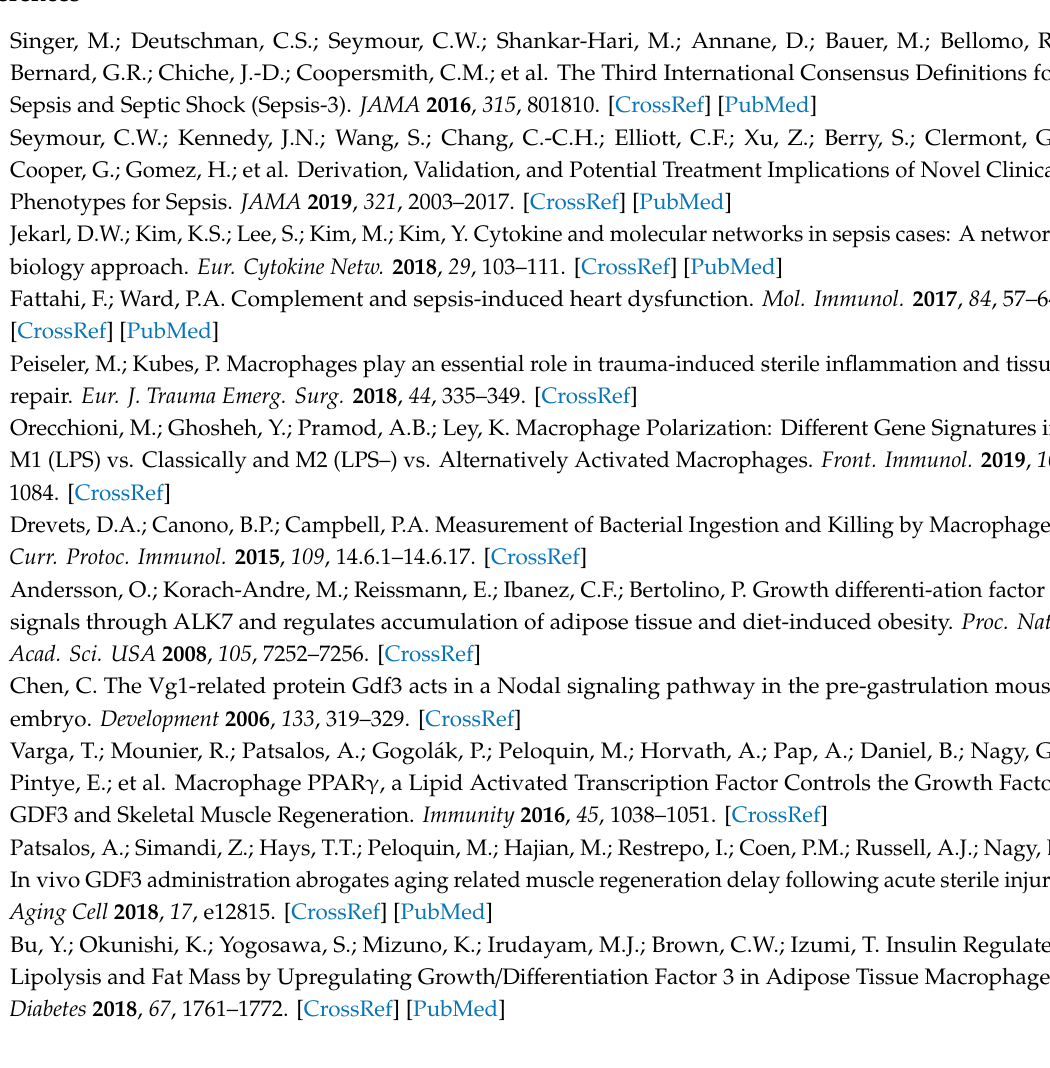
Table S1: Demographics and clinical details about non-shock sepsis; Table S2. The primer sequences for RT-PCR; Table S3. AUC analysis for 28-day mortality prediction within the derivation; Figure S1. GDF3 does not a ff ect BMDM phenotype after fully di ff erentiation from bone-marrow stem cells; Table S4. Echocardiographic analysis for cardiac function in LPS-mice treated with or without